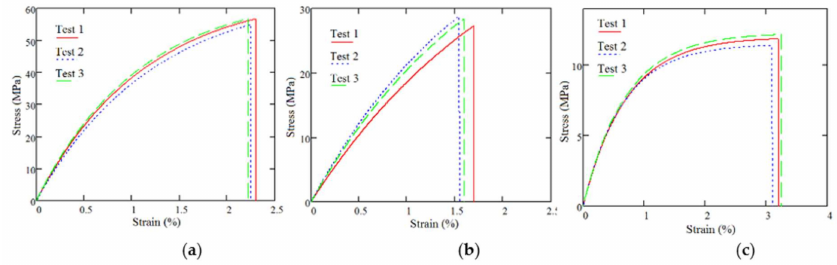
Figure 6. Stress vs. strain data for CFRP-Nylon printed at 0 ◦ ( a ), 90 ◦ ( b ), and ± 45 ◦ ( c ). Table 1. Mechanical properties of carbon fiber-reinforced polymer (CFRP)-Nylon.